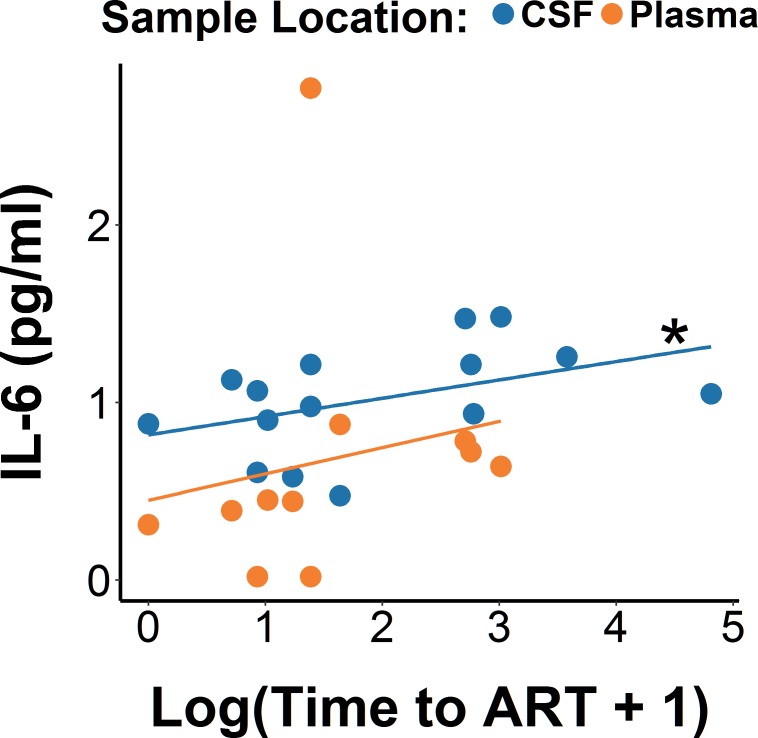
Regression analysis between time to ART start and IL-6 levels in blood and CSF.Linear mixed-effects regression models revealing relationship between levels of IL-6 with log-transformed time to ART start. *p<0.05 for the correlation within CSF.